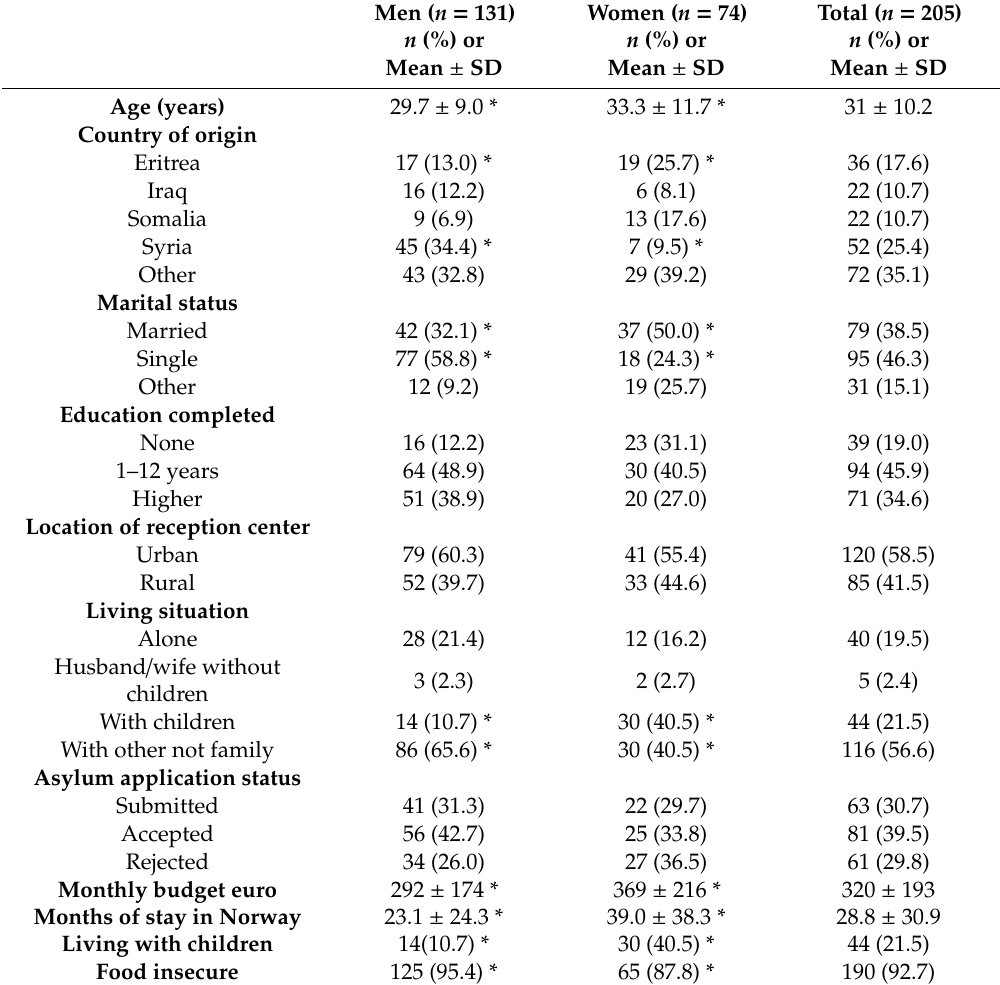
Table 1. Background information on asylum seekers in reception centers in southeastern Norway ( n = 205) by gender and in